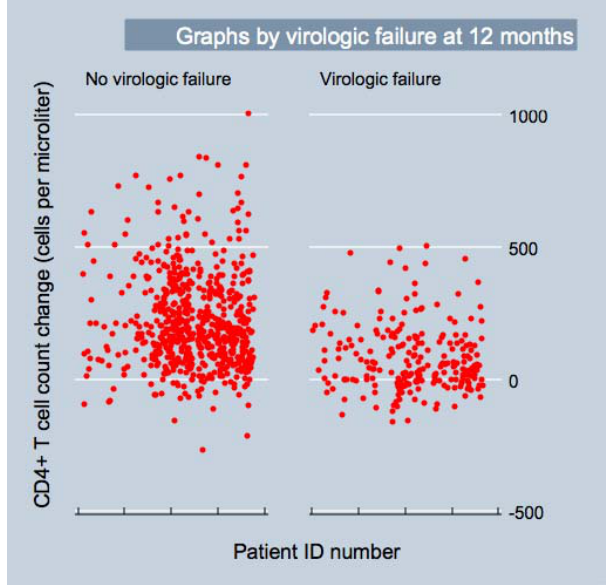
Figure 5. Scatter Plot of CD4 Count Change (cells/ l l) at 12 Months after Starting cART for Patients with and without Virologic Failure